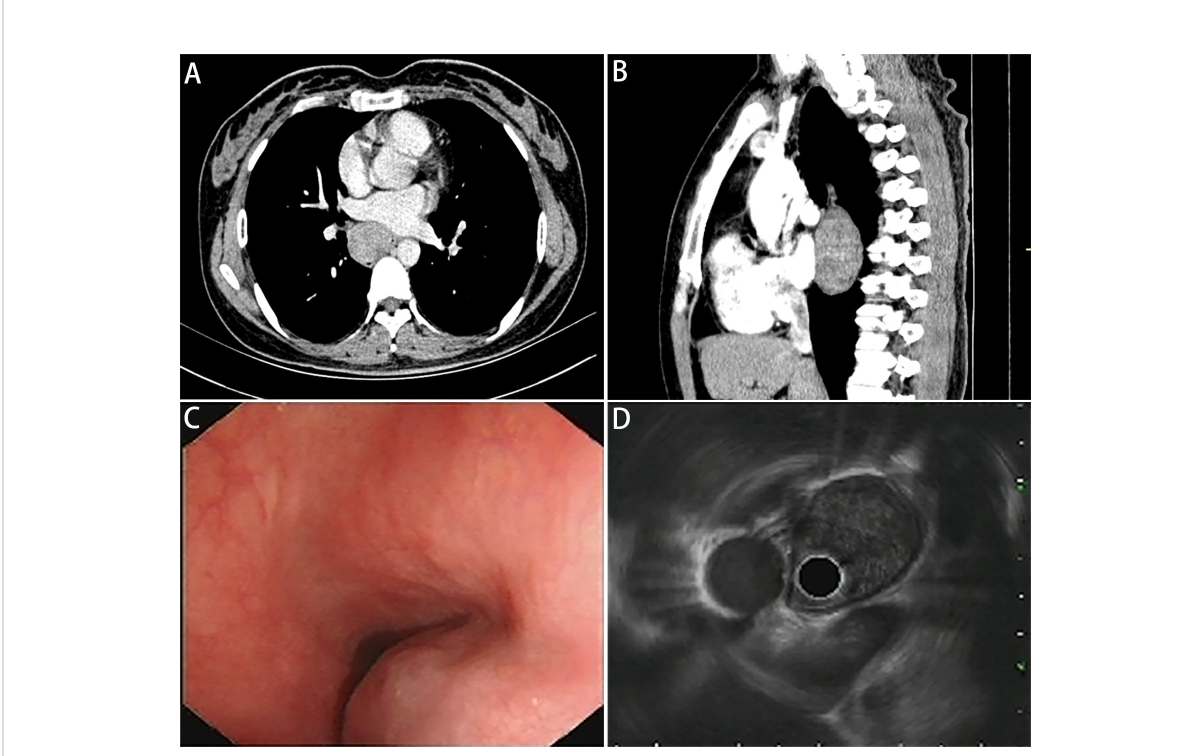
FIGURE 1 Images of pulmonary mediastinum CT and echogatstroscopy. (A) Transverse position and (B) sagittal position of pulmonary mediastinum CT show a mass located in the right posterior mediastinum approximately 37 × 28 × 67 mm in size, and the boundary with the adjacent esophagus is unclear. (C) The white light endoscopy view and (D) endoscopic ultrasound image show a 34.5 mm × 32.6 mm semispherical uplift with smooth surface mucosa and intraluminal growth pattern originating from the esophageal submucosal layer, with uniform hypoechoic change and a clear